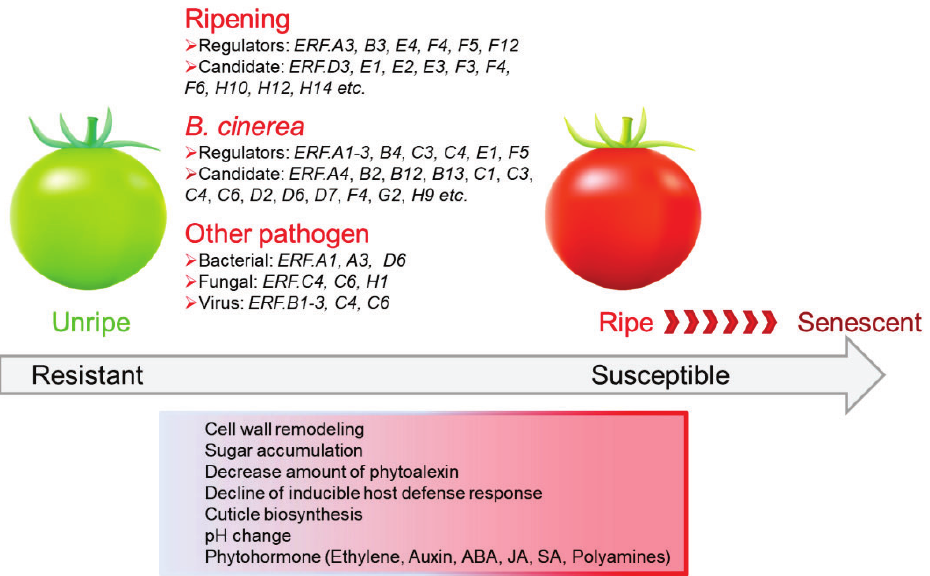
Table 2. ERFs involved in pathogenic responses of other fleshy